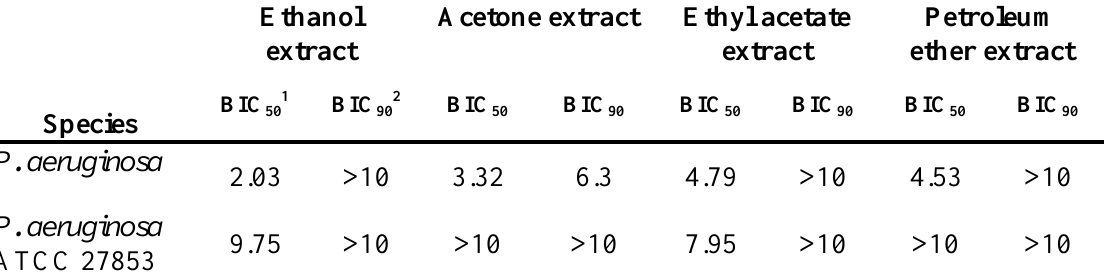
Table 4. Antibiofilm activity of extracts from P.